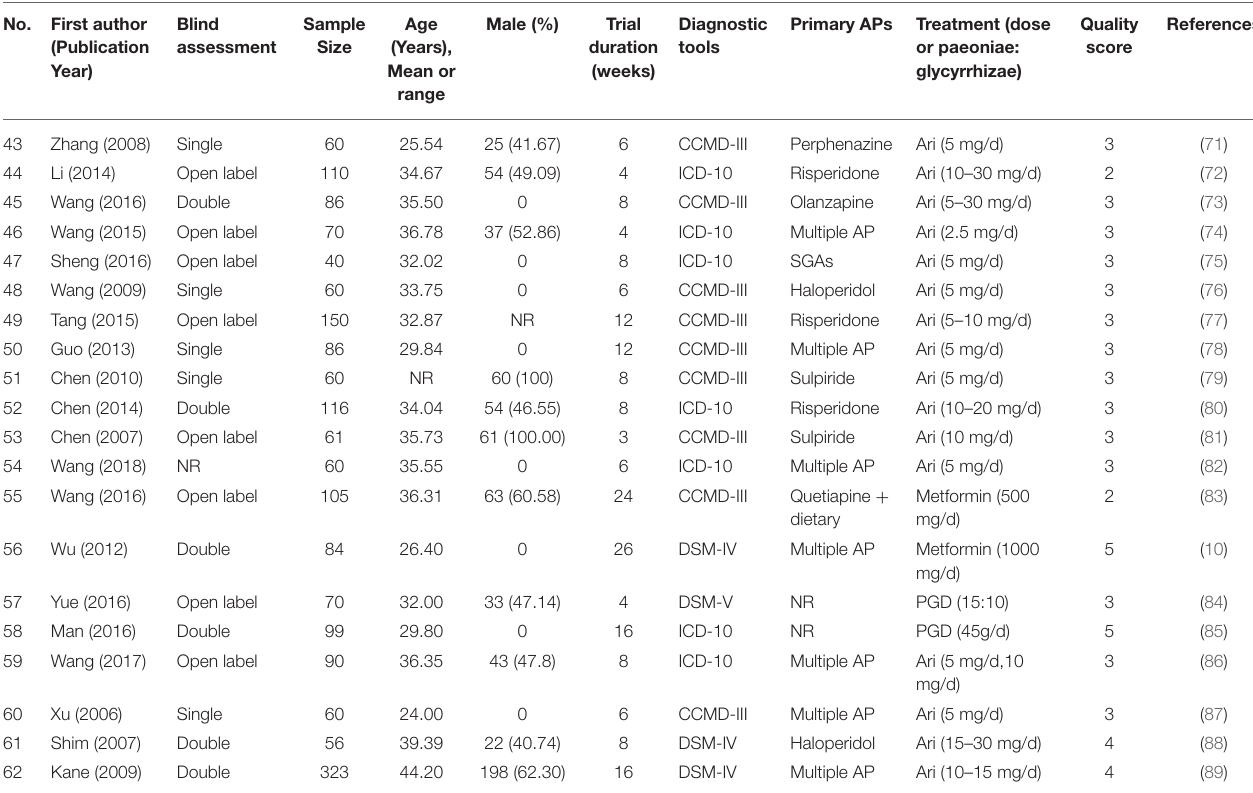
= − 65.52, 95% CI = − 104.91, − 24.08) and the other eight treatment groups ( Table 2 ) (the best probability, PrBest = 56.3%) ( Table 3 ), followed by aripiprazole at > 10 mg/day (posterior MD = − 45.85, 95% CI = − 60.69, − 31.55) and aripiprazole at 5 mg/day (posterior MD = − 45.59, 95% CI = − 55.89, − 35.75).